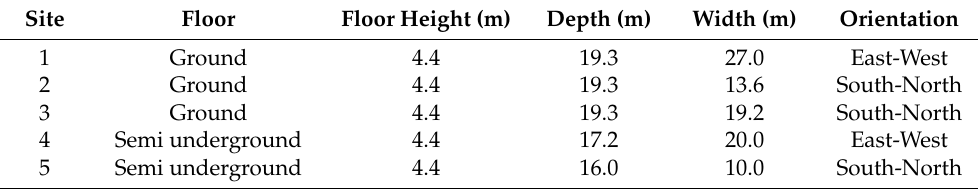
Figure 2. The campus and site information. (Photos taken by the authors). Table 1. Information on the measurement sites.